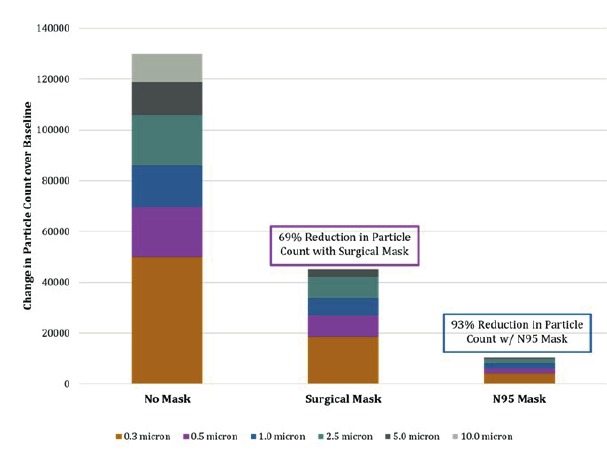
Figure 3. Effect of PPE on Simulated Sneeze. Mean change in particle count from baseline for simulated sneeze with and without PPE. The breakdown of particle size is shown within each test. The surgical mask reduces HCP aerosol exposure by 69% (p=0.012) and the N95 mask reduces aerosol exposure by 93% (p=0.003).